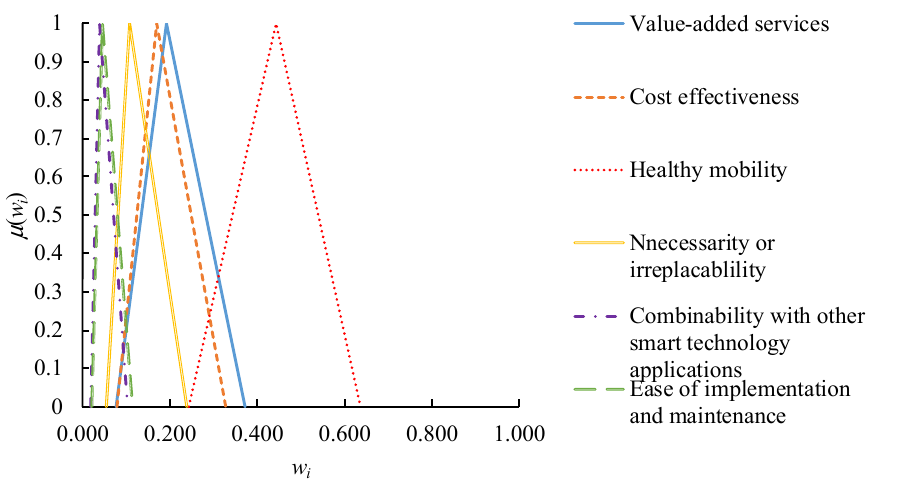
Figure 3. Procedure for the CFGM-FTOPSIS approach.